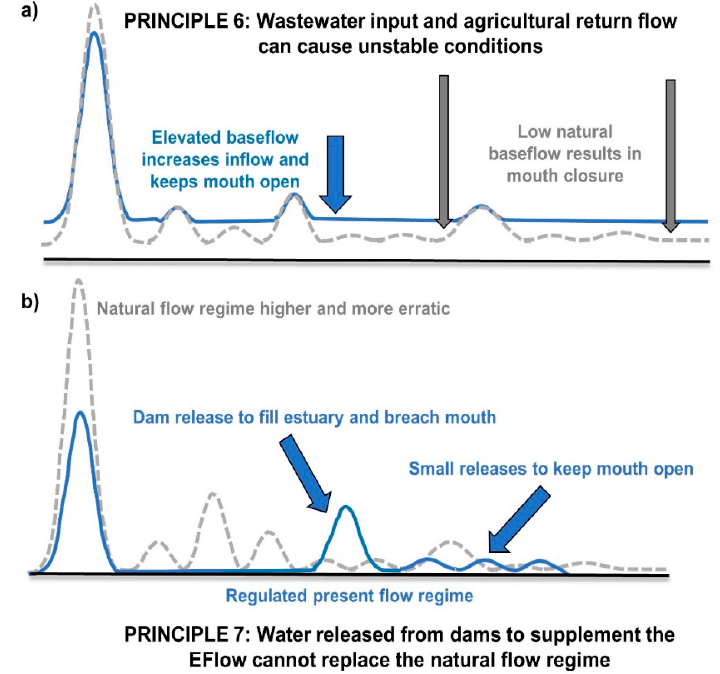
Figure 10. Graphics comparing ( a ) natural and elevated baseflows, highlighting their effect on estuary mouth condition, and ( b ) flow patterns from natural flow regimes and those of regulated dam releases.